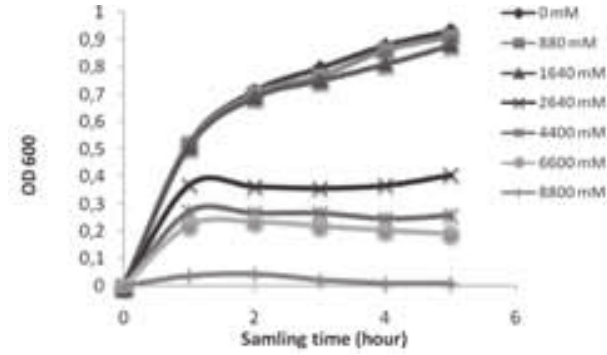
Fig. 3: Oxidative stress tolerance of bacterium A4 in liquid SLP medium supplemented by increasing concentrations of H